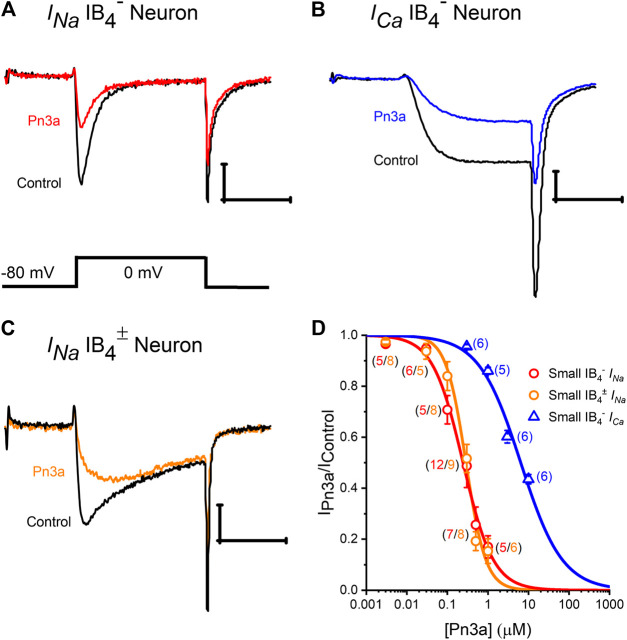
Pn3a inhibition of TTXs-I
Na and high voltage-activated I
Ca in rat DRG neurons. (A–C) Representative recording of control (black) INa in IB4
− and IB4
± DRG neurons (red and orange, respectively) in the presence of 0.3 µM Pn3a. (B) HVA I
Ca currents from DRG neurons in control (black) and the presence of 10 µM Pn3a (blue). (D) Concentration-response curves obtained for Pn3a inhibition of TTXs-I
Na in small-diameter IB4
− (red) and small-diameter (5–60 pF) lightly IB4
± (orange) neurons and I
Ca in small-diameter IB4
− (blue) neurons (n values shown for each concentration). X scale bar 5 msec; Y scale bar 0.5 nA.